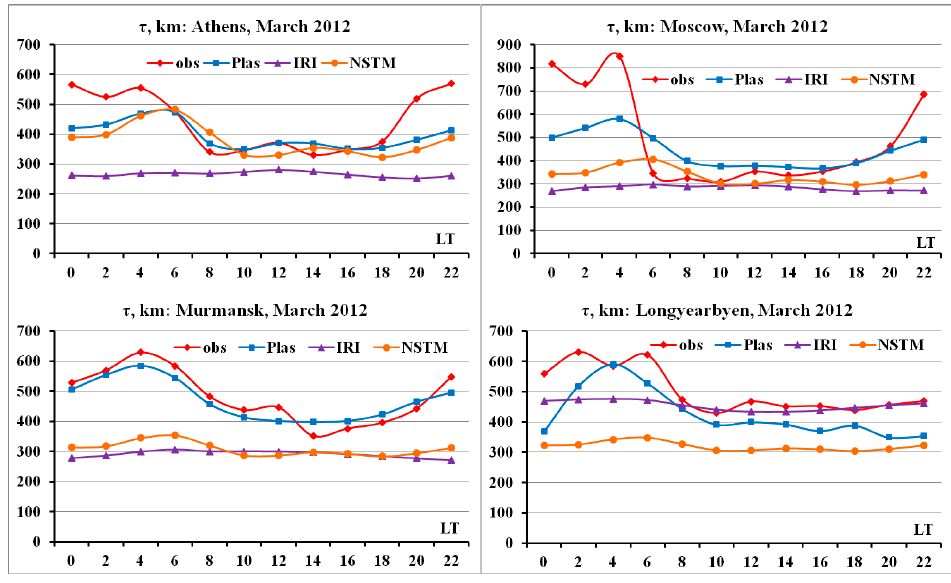
Figure 3. Comparison of τ for different models. Statistical characteristics of τ (obs) for the various stations, including RMSE in km and NRMSE in %, are provided in Table 1. Table 1. τ metrics for four stations.